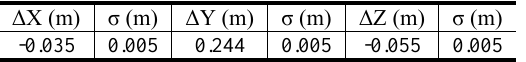
Table 1. Lever arm coordinates and their standard deviations.